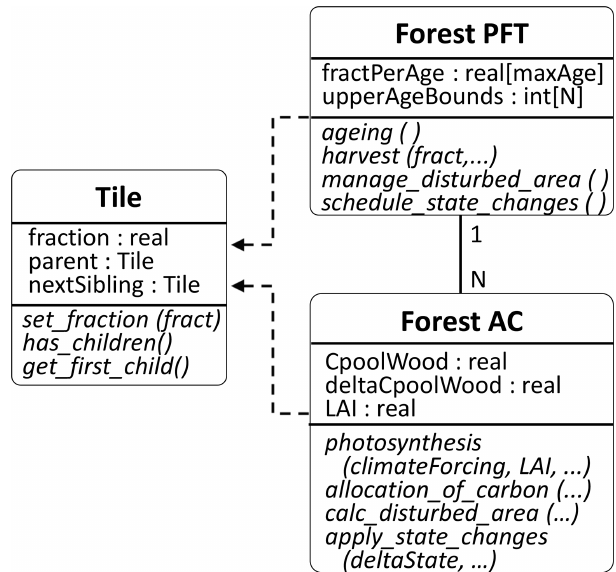
Figure 2. Unified Modelling Language diagram showing the re- lation between tiles, forest plant functional types (PFTs), and for- est age classes (ACs) in JSBACH4–FF, together with a selection of example state variables and functions (in italics). Forest PFTs and ACs are distinct types of tiles, with each PFT having N asso- ciated ACs. Each tile hosts certain state variables, for example the grid-cell fraction that it covers, as well as functions, for example to navigate the tile hierarchy. Different types of tiles add further variables and functions. Tiles representing ACs host variables and functions required for processes calculated on the lowest level of the tile hierarchy, such as photosynthesis or carbon allocation. Tiles representing PFTs host variables to maintain meta-information, for example the fractPerAge vector, which contains the fraction cov- ered by each age, i.e. one entry per year up to the maximum tracked age (maxAge). Furthermore, PFTs host functions altering more than one associated AC, for example ageing or